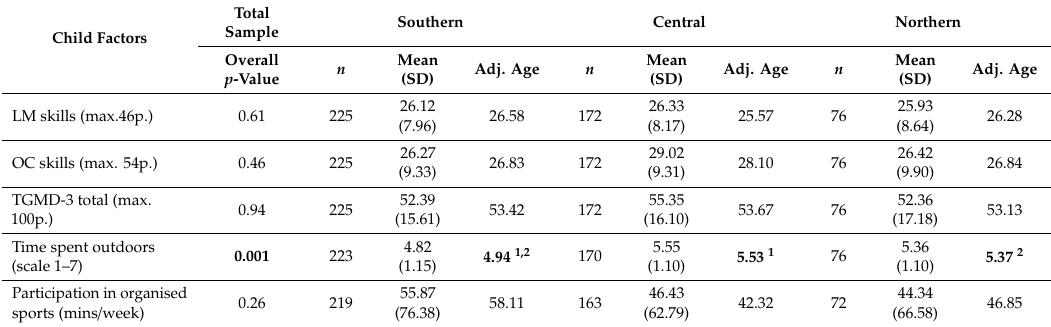
Table 4. Geographic location: di ff erences in